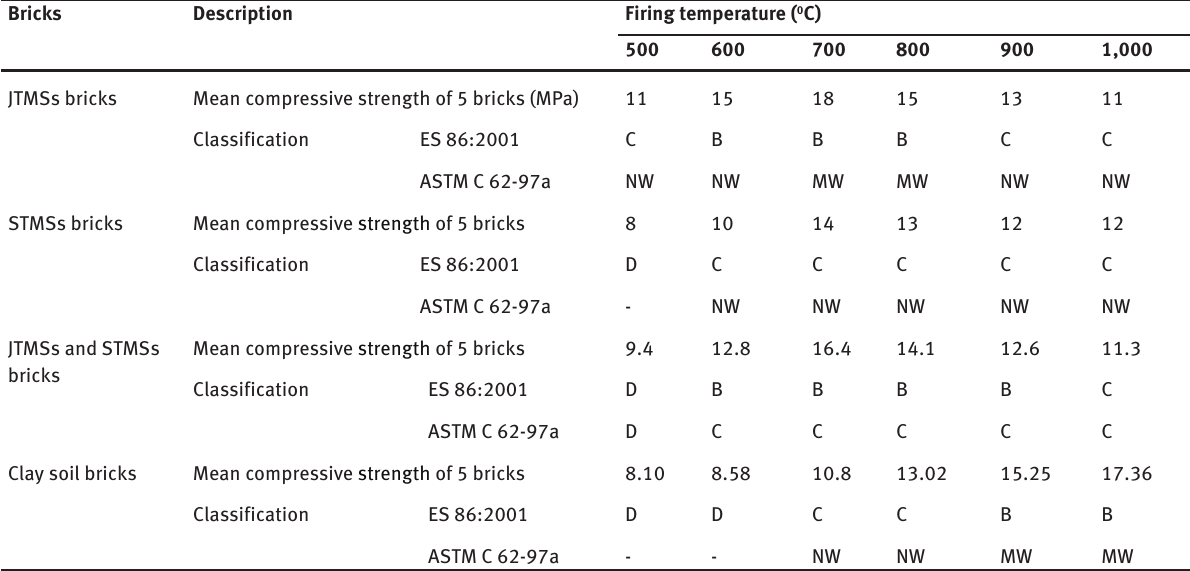
Table 5: Mean compressive strength of five bricks and their classifications.